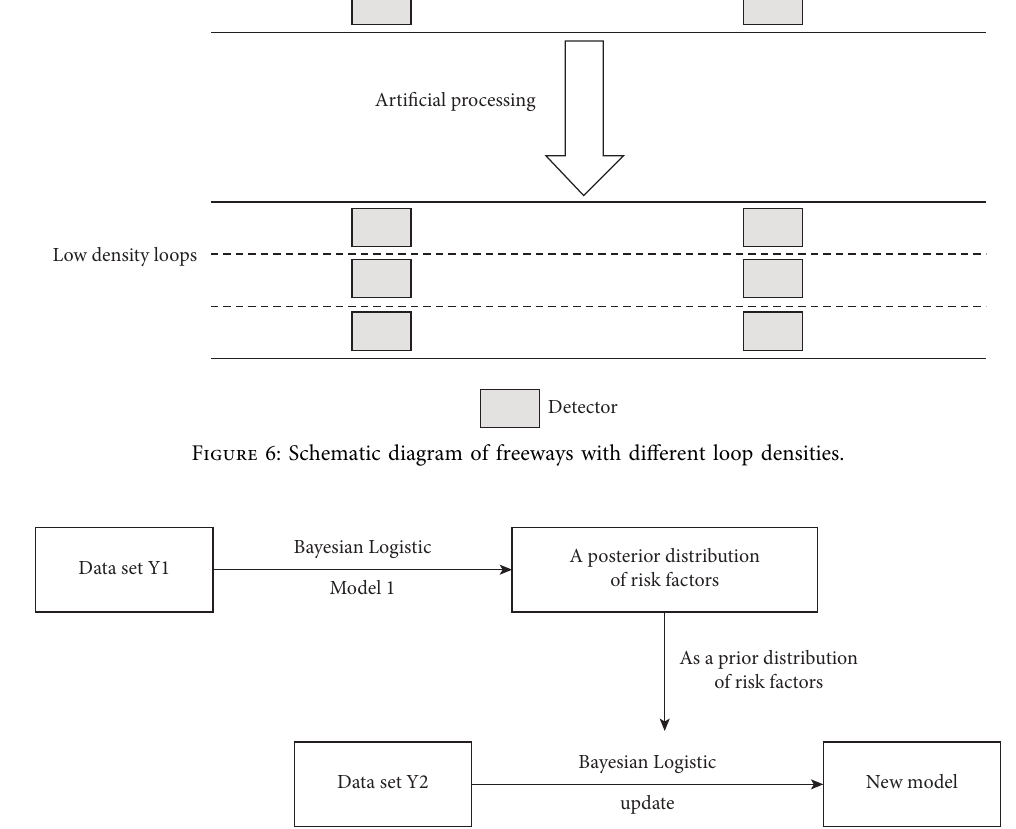
Figure 7: Schematic diagram of Bayesian updating